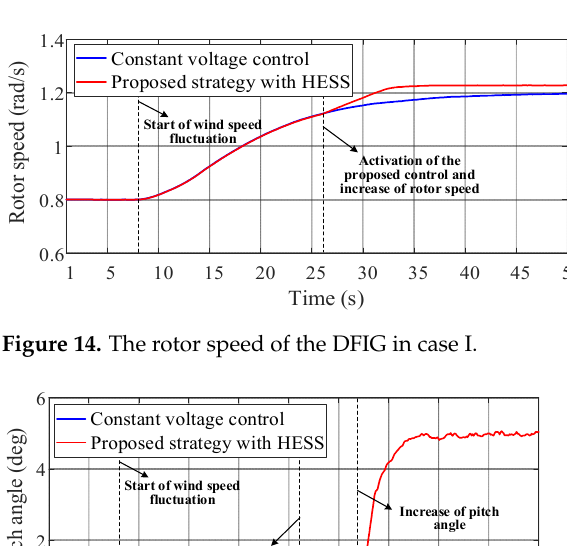
Figure 13. The output reactive power of the wind farm in case I .